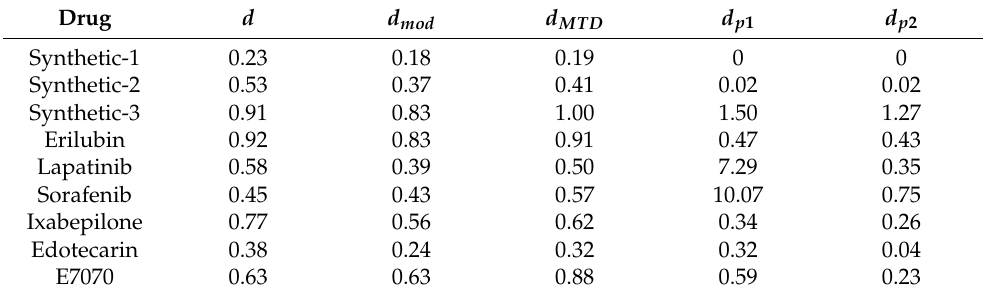
Table 3. Results in terms of d , d mod , d MTD , d p 1 and d p 2 for the synthetic examples and the real